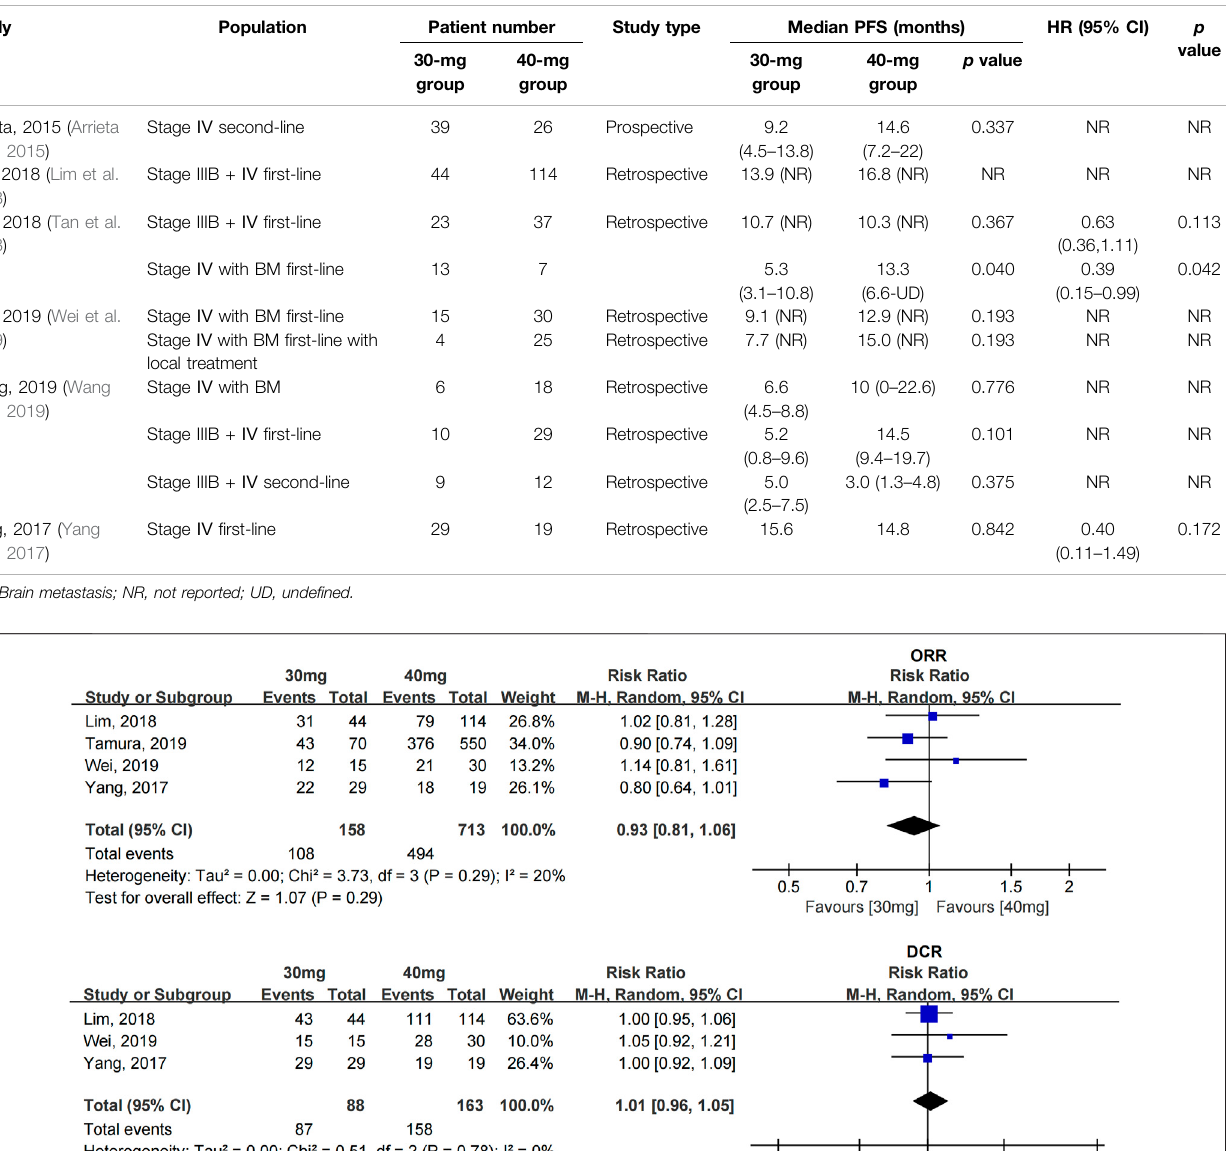
TABLE 2 | Survival results of the six studies comparing patients using 30 and 40 mg afatinib.